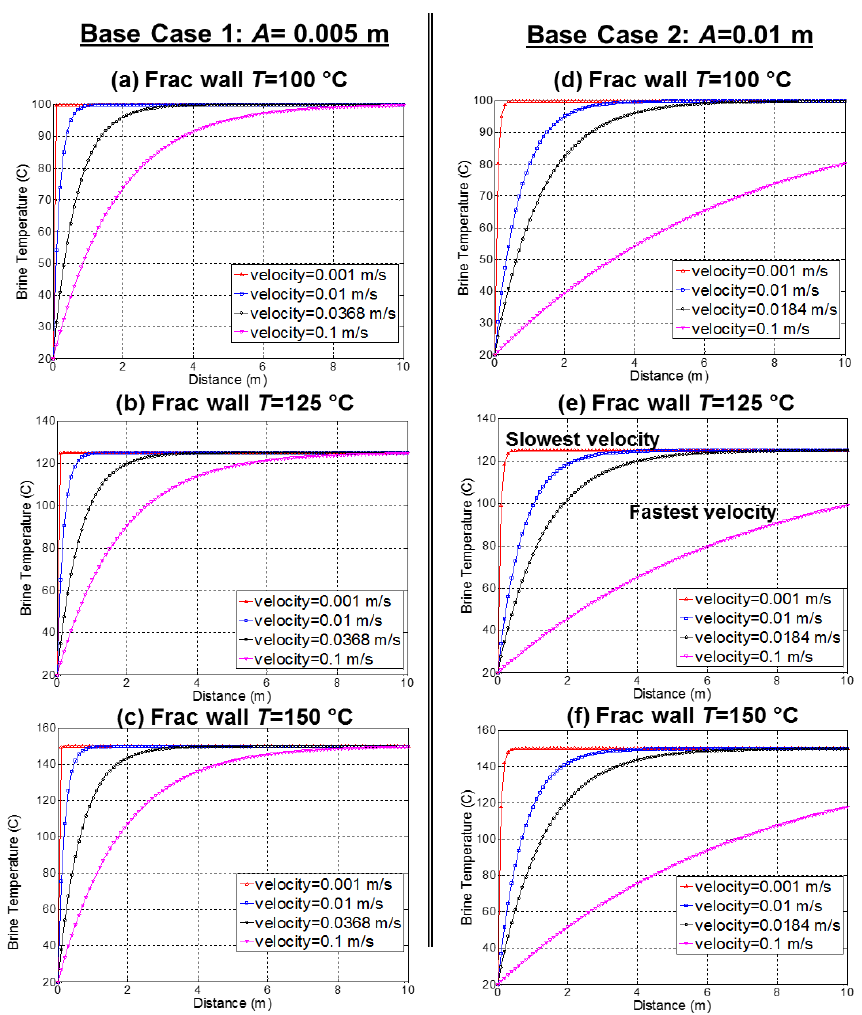
Figure 6. Temperature profiles for various injection flow rates when surface temperature of the fracture wall rock is 100 °C, 125 °C, and 150 °C for Base Case 1 and Base Case 2, and the total flow rate at the producer wells is between 0.005 m 3 /s to 0.5 m 3 /s. Fracture apertures and surface temperatures are ( a ) 0.005 m, 100 °C; ( b ) 0.005 m, 125 °C; ( c ) 0.005 m, 150 °C; ( d ) 0.01 m, 100 °C; ( e ) 0.01 m, 125 °C; ( f ) 0.01 m, 150 °C.